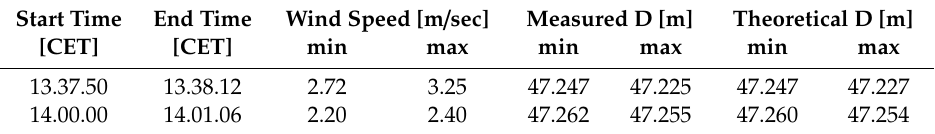
Table 5. Theoretical and measured ground distances from TLS of a point 65 m high.